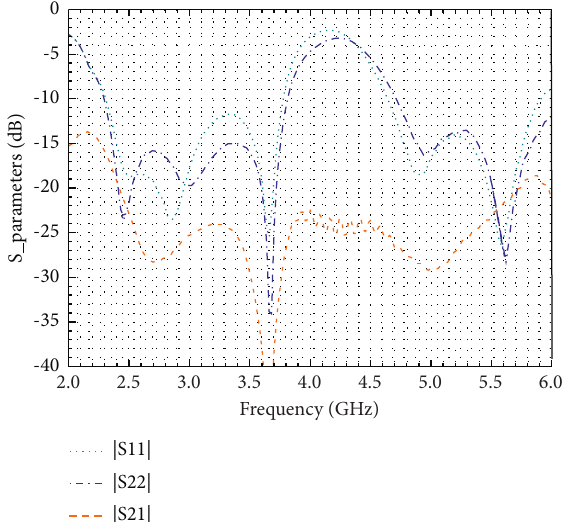
Figure 7: Measured S parameters of the proposed